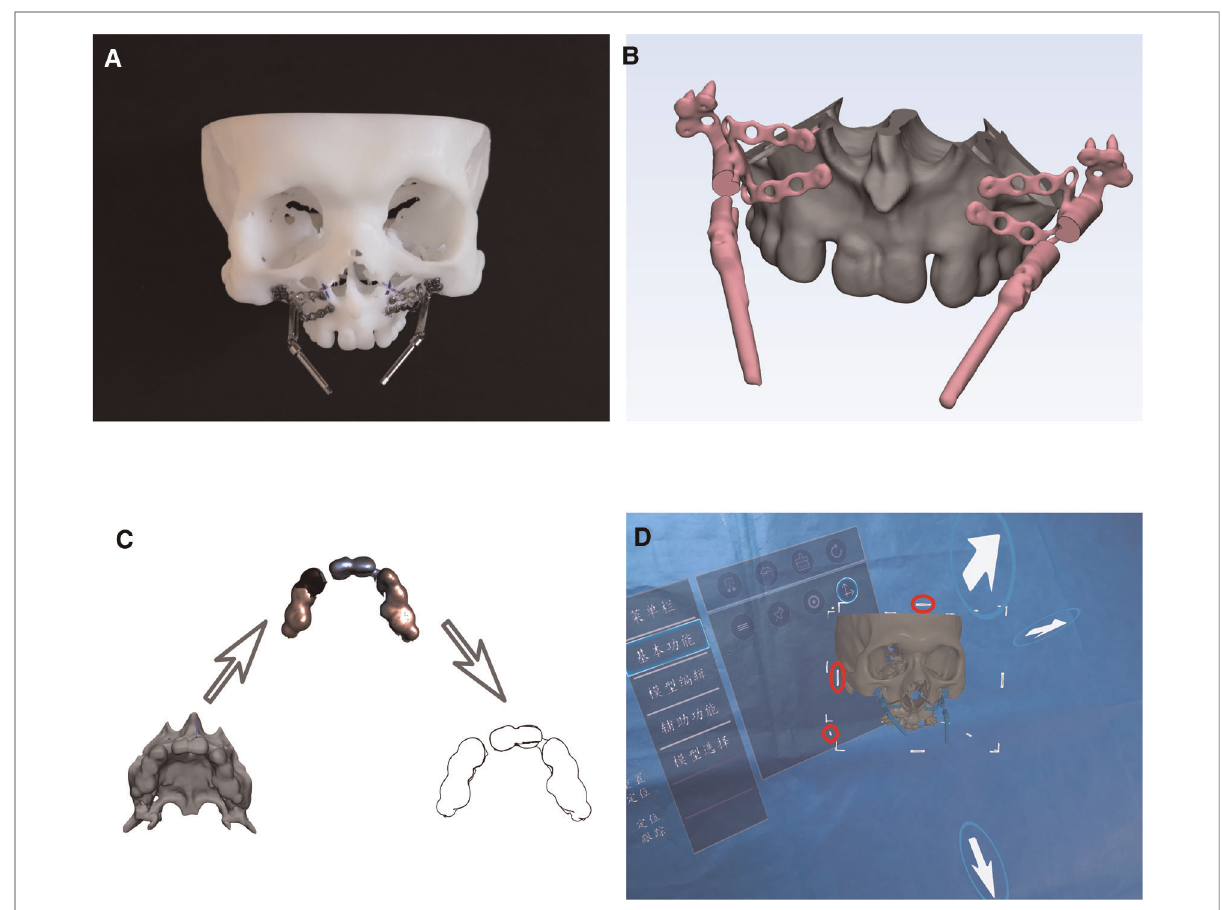
FIGURE 3 Pre-operative plan and navigation preparation note: ( A ) distractors pre-bending on the planning phantom. The blue marks around the osteotomy line were used to check that the distal bone block was in its original position after the osteotomy, indicating that the pre-bent distractors were not exerting unexpected pressure on the bone block. ( B ) Navigation model design. Two “ windows ” (black arrows) were set in the middle of bilateral driver screws as an additional visual clue to facilitate vector checking and fi ne adjusting. ( C ) Dentition contour extraction for automatic calibration function. ( D ) This study ’ s “ coordinate fi ne-tuning ” function of AR surgical navigation. The three arrows allowed continuously variable translation adjustment of the hologram, while the parts marked by red ovals allowed continuously variable rotation